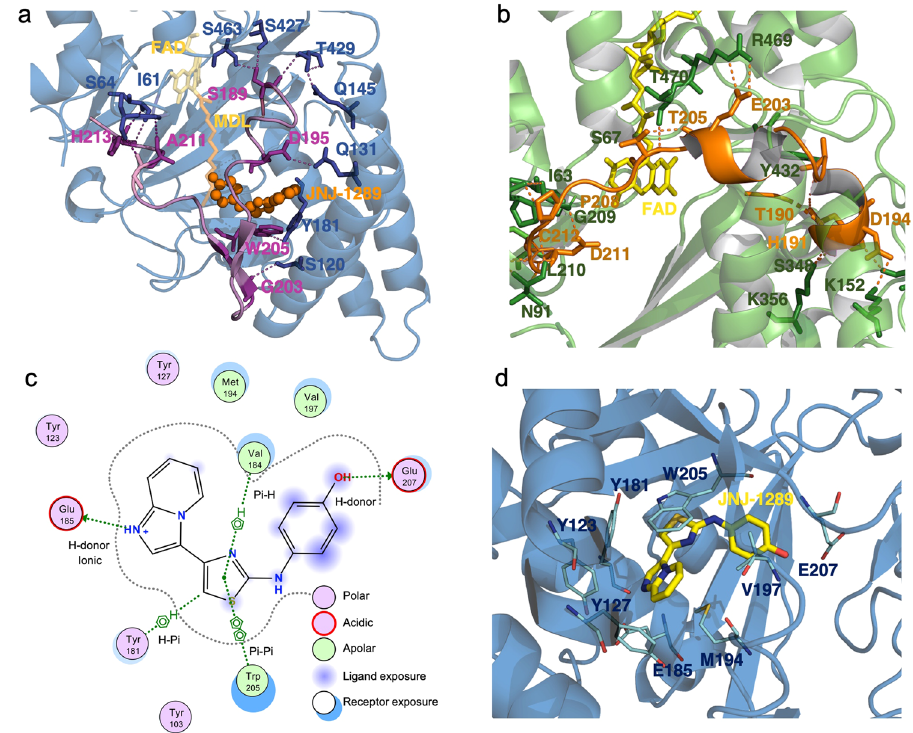
Fig. 7 ehSMOX and mPAOX substrate loop position and binding pocket of JNJ-1289 on ehSMOX. a ehSMOX in a blue cartoon with FAD and MDL72527 in yellow and orange transparent sticks; JNJ-1289 in orange spheres. In pink ribbon is depicted the fl exible loop above the substrate pocket, in violet sticks, are the residues of that loop involved in intramolecular H-bonds (dotted lines) with residues (blue sticks) in the main body of the protein. b mPAOX (PDB: 5MBX) in a green cartoon with FAD in yellow. The loop above the substrate pocket is colored in orange, and orange and in green sticks are indicated residues involved in intramolecular H-bonds (orange dotted lines) belonging to the loop and to the rest of the protein, respectively. c JNJ-1289 interactions with ehSMOX residues. d JNJ-1289 (in yellow sticks) interactions with ehSMOX represented in blue ribbon. Residues involved in H-bonds (cyan dashed lines) or π -interactions (yellow dashed lines) are depicted in cyan